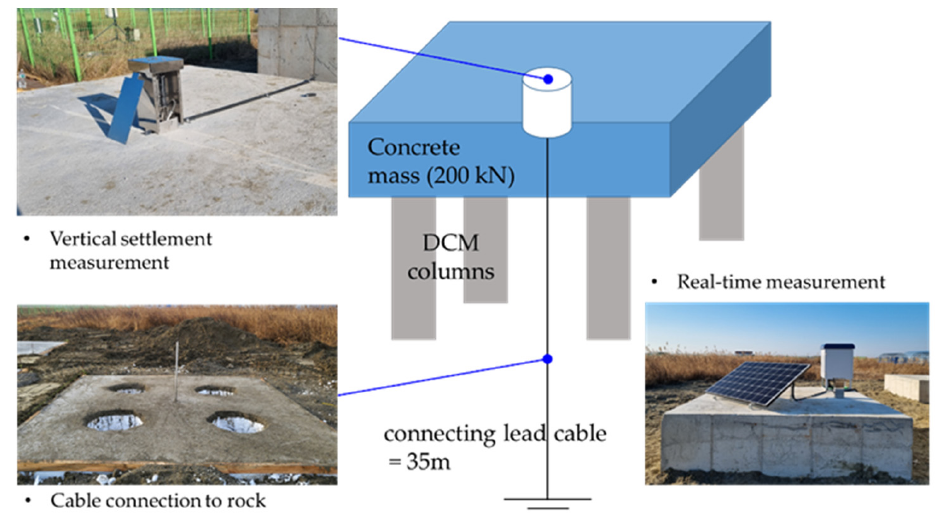
Figure 2. Settlement monitoring system.